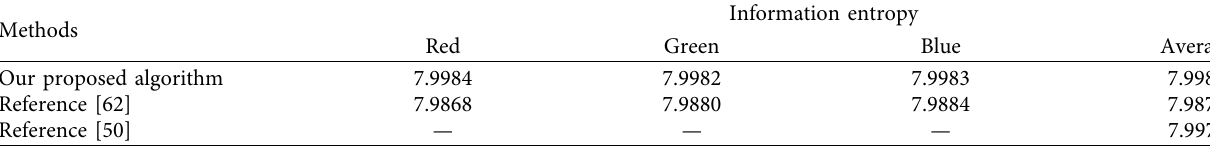
Table 8: The results of information entropy.